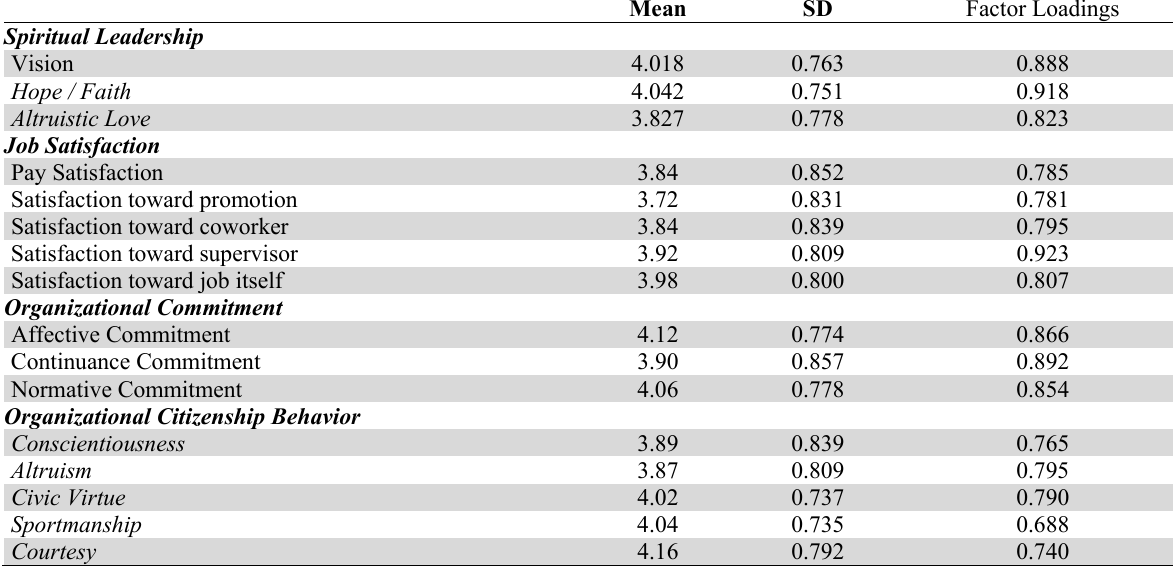
Mean, Standard Deviation and Factor